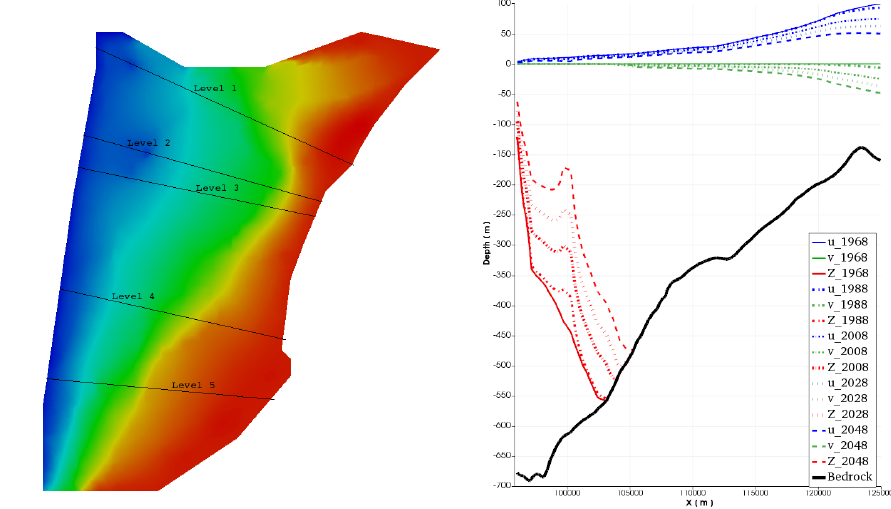
Figure 15. Left : Plan view of level positions. Right : vertical cross section showing the interface position (red line), the free surface position (blue line) and the variation of the saltwater hydraulic head (green line) for different times: cut on the level